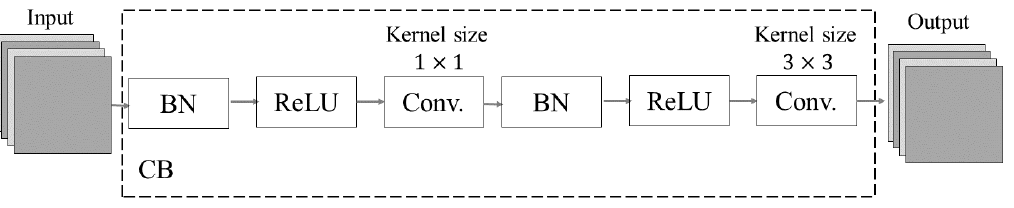
Figure 3. The structure of CB.